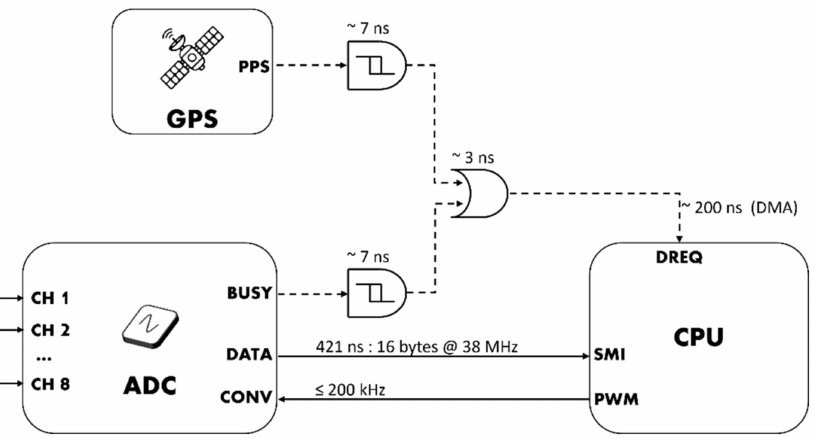
Figure 5. Interrupt conversion and detection scheme; propagation time is reported next to the respective logic gate, whereas for DREQ the time refers to DMA latency.